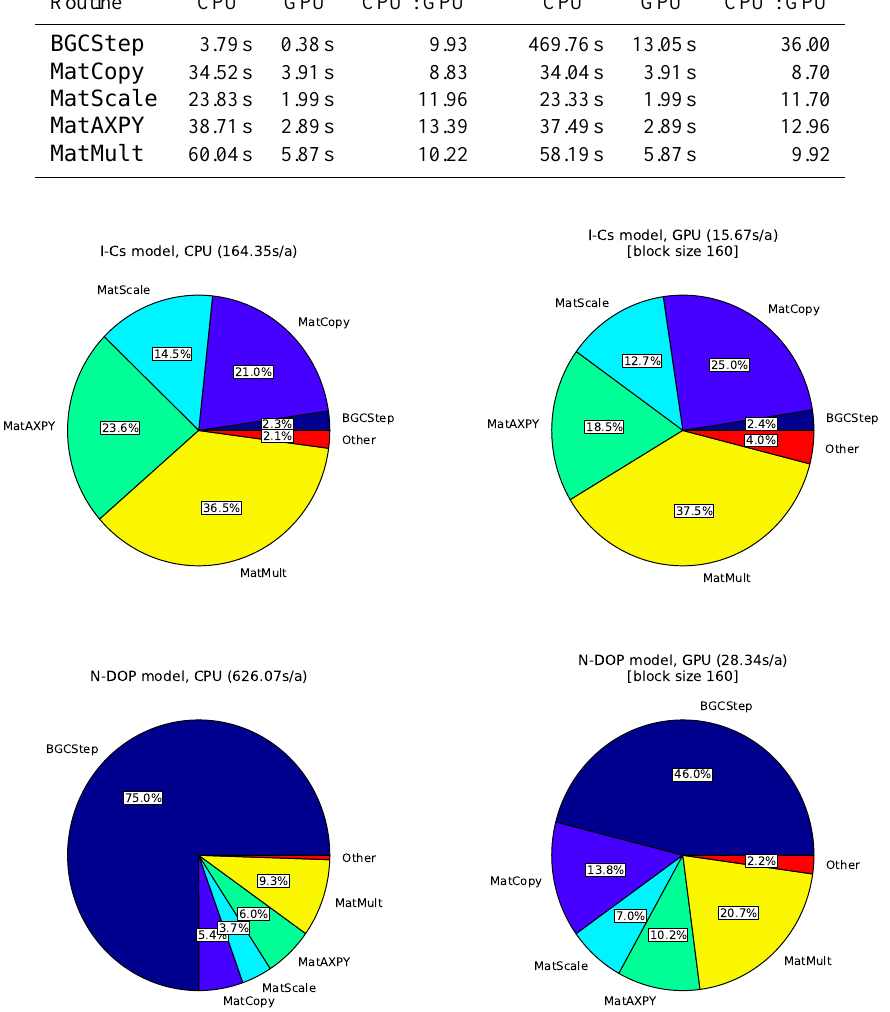
Fig. 4. Fraction of computational time needed for the individual parts in one year of the spin-up (Algorithm 1 and Table 4) for the I-Cs (top) and the N-DOP (bottom) model on the CPU (left) and GPU (right).